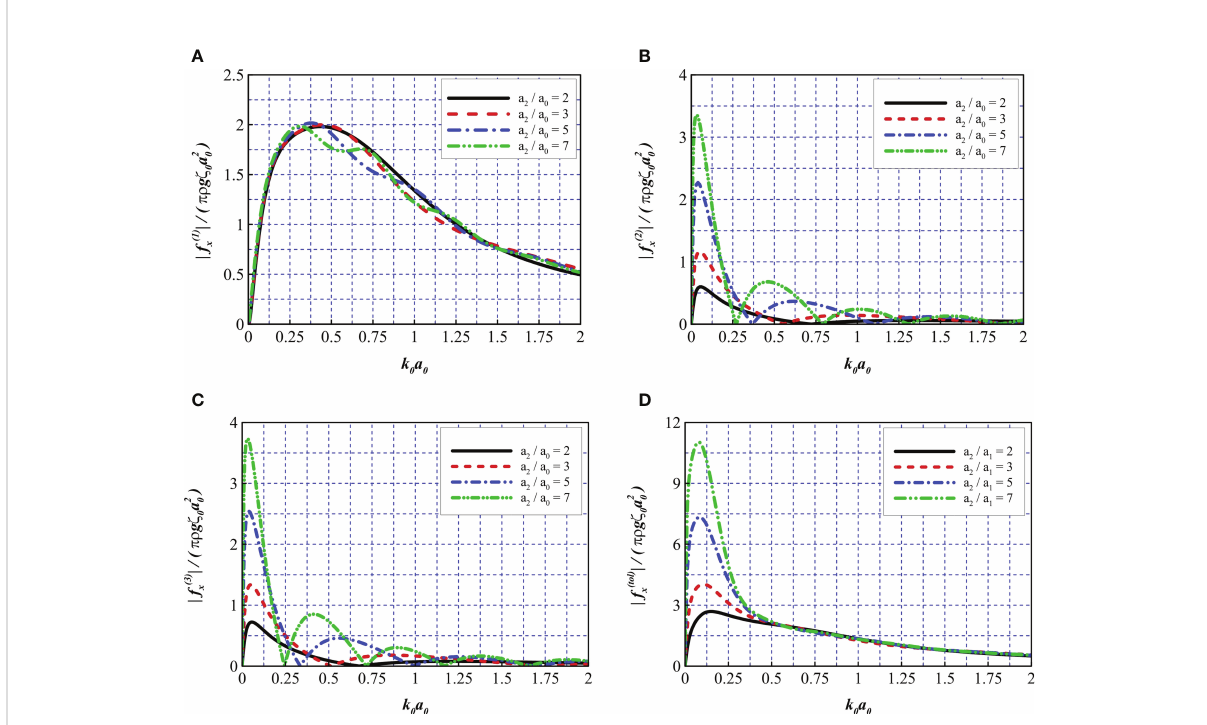
FIGURE 14 Comparison of wave force for different radius ratios of the friction wheel to the wind turbine tower. (A) j f (1) x j = ( pr g z 0 a 2 0 ), (B) j f (2) x j = ( pr g z 0 a 2 0